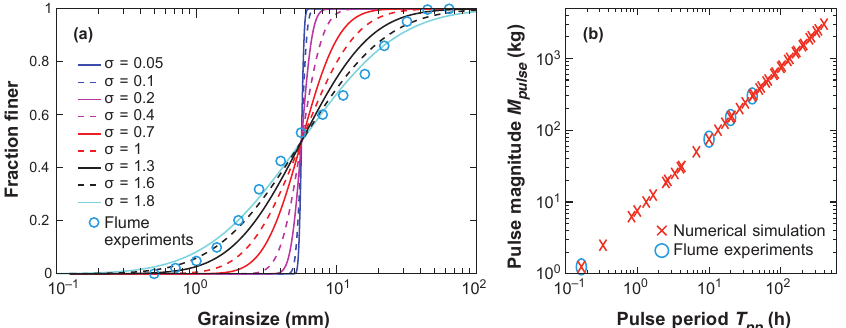
Figure 2. (a) Variation of the grain size distribution between model runs (lines) and values from the flume experiments (circles). All distributions have a geometric mean grain size ( D sg ) of 5.64mm. The different σ values represent the width of the distribution, calculated for normal distributions in phi-scaled sediment sizes. The data for the flume experiments are roughly matched with σ = 1 . 6. (b) Combinations of pulse magnitude and pulse period (or recurrence interval) used in the equilibrium model runs. As the total mass of supplied material is the same for all simulations, runs with high pulse frequencies (i.e., low pulse periods T pp ) are smaller in magnitude. Four of the combinations match the flume runs